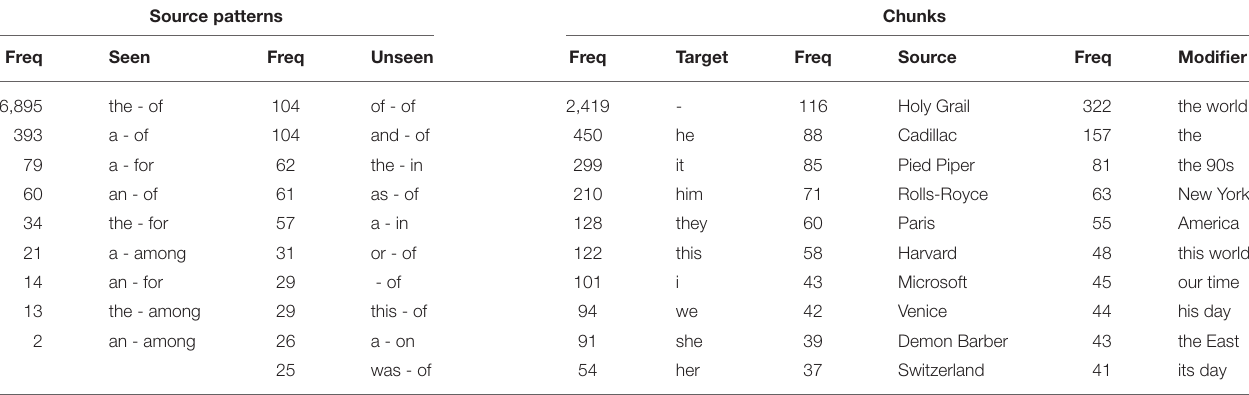
TABLE 9 | Top 10 predicted source patterns [split into seen (only nine exist) in the training data and unseen (new)] and top 10 predicted VA chunks. Source patterns